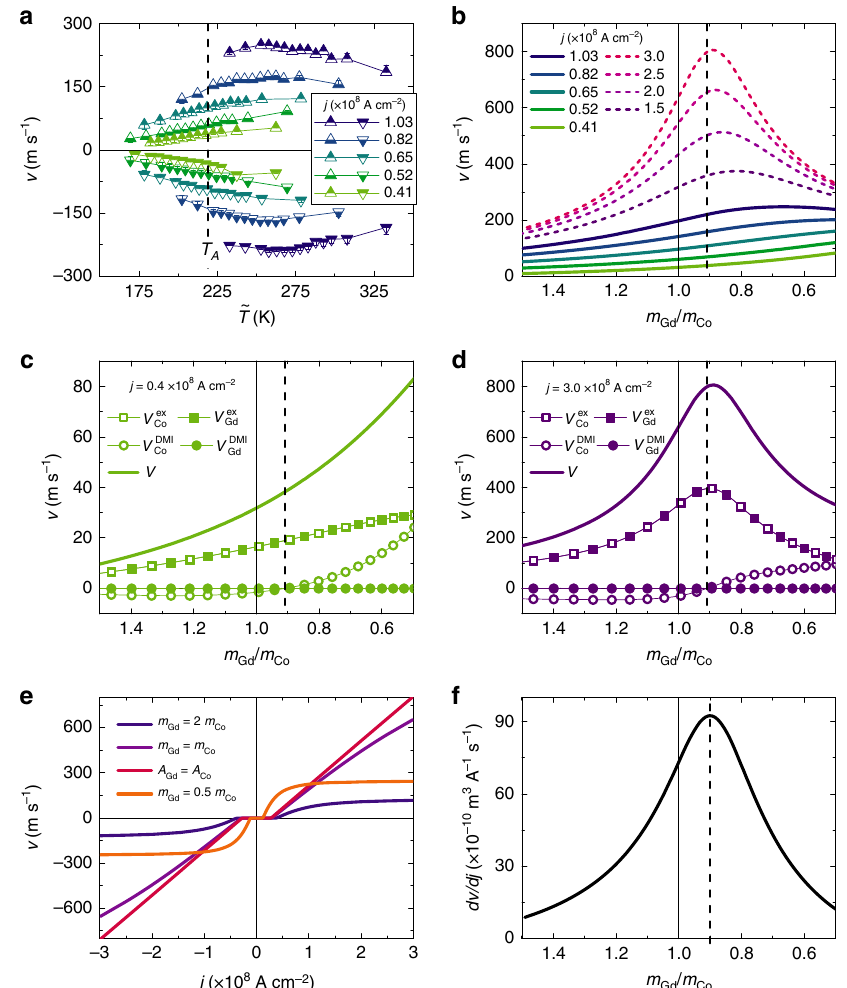
Fig. 4 Contribution of ECT to CIDWM. a Experimentally measured DW velocity v vs. ~ T for positive (triangle up) and negative (triangle down) current. Joule heating is taken into account (c.f. Supplementary Fig. 6). Error bars re fl ect systematic error due to constant resistance assumption (c.f. Methods). b Solutions of analytical model for steady state CIDWM of an ↑↓ DW for positive current densities. The curves ’ color matches with that of the experimentally applied current densities shown in a . Additional solutions for j = 1.5, 2.0, 2.5 and 3.0 × 10 8 A cm − 2 are plotted. (c,d) Dependence of v (solid line) and the contributions to v from DMI (circles) and ECT (squares) for j = 0.41 ( c ) and 3.00 × 10 8 A cm − 2 ( d ). Open and closed symbols correspond to the Co and Gd layers, respectively. e DW velocity dependence on j for various ratios m Gd / m Co . f Ef fi ciency dv / dj of CIDWM at 3.0 × 10 8 A cm − 2 depending on m Gd / m